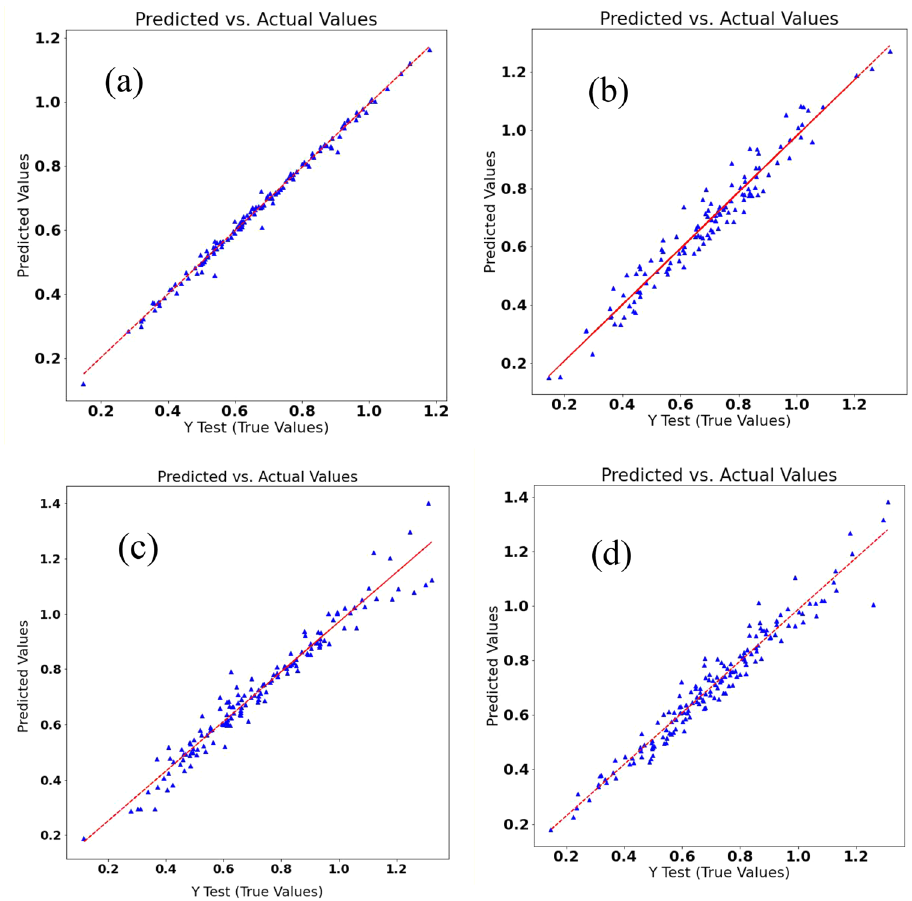
Figure 3. ( a ) Linear ( b ) Support vector, ( c ) Random forest, and ( d ) gradient boosting regressions of the grain yield per plant of the Lallemantia iberica